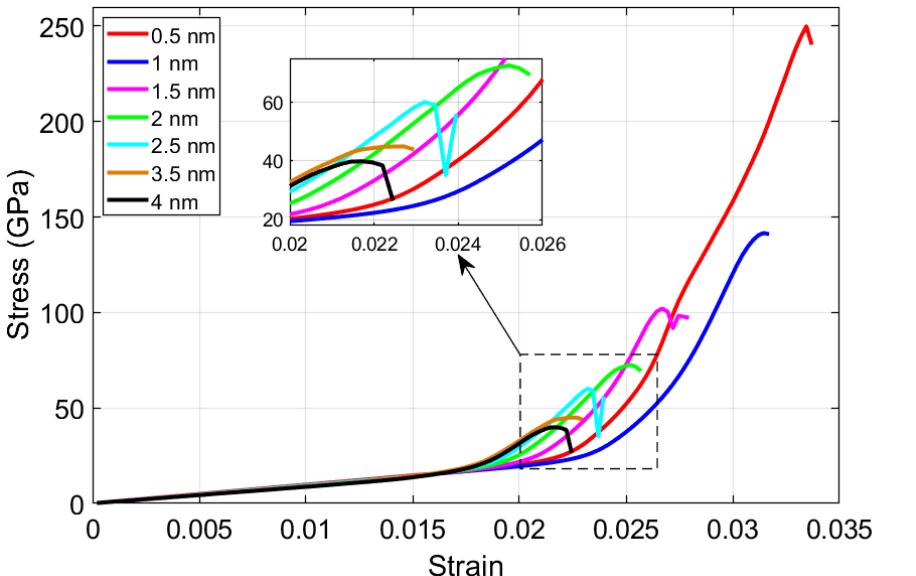
Figure 6. Crack size effect on the stress-strain relationship: A rectangular crack is generated in tTLG before tensile simulations under the conditions of temperature T = 300 K, pressure P = 0.0001 GPa, system size 4 × 4, and strain rate 1 × 10 9 s − 1